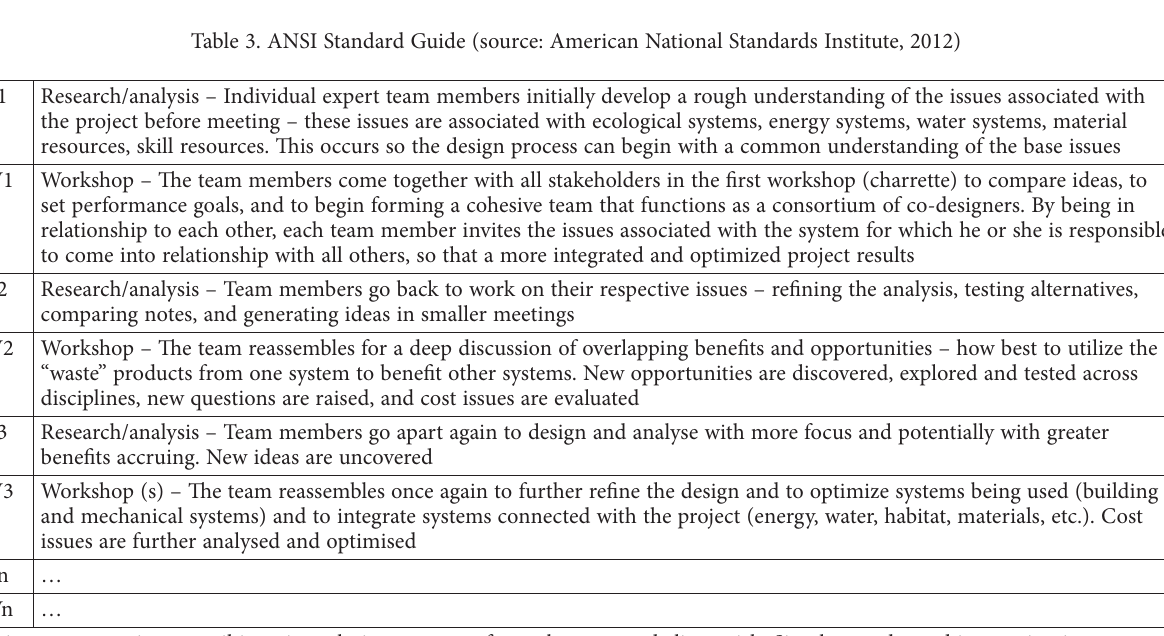
Table 3. ANSI Standard Guide (source: American National Standards Institute,